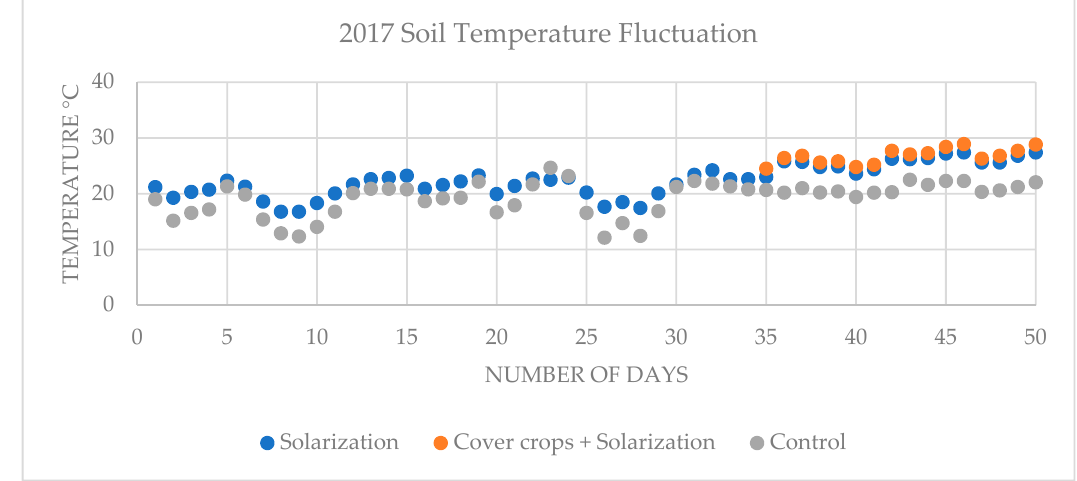
Figure 2. Soil temperature fluctuation in the top 15 cm of solarized beds, cover crops incorporated solarized beds and control non-treated, non-solarized beds in the 2017 on-farm experiment.